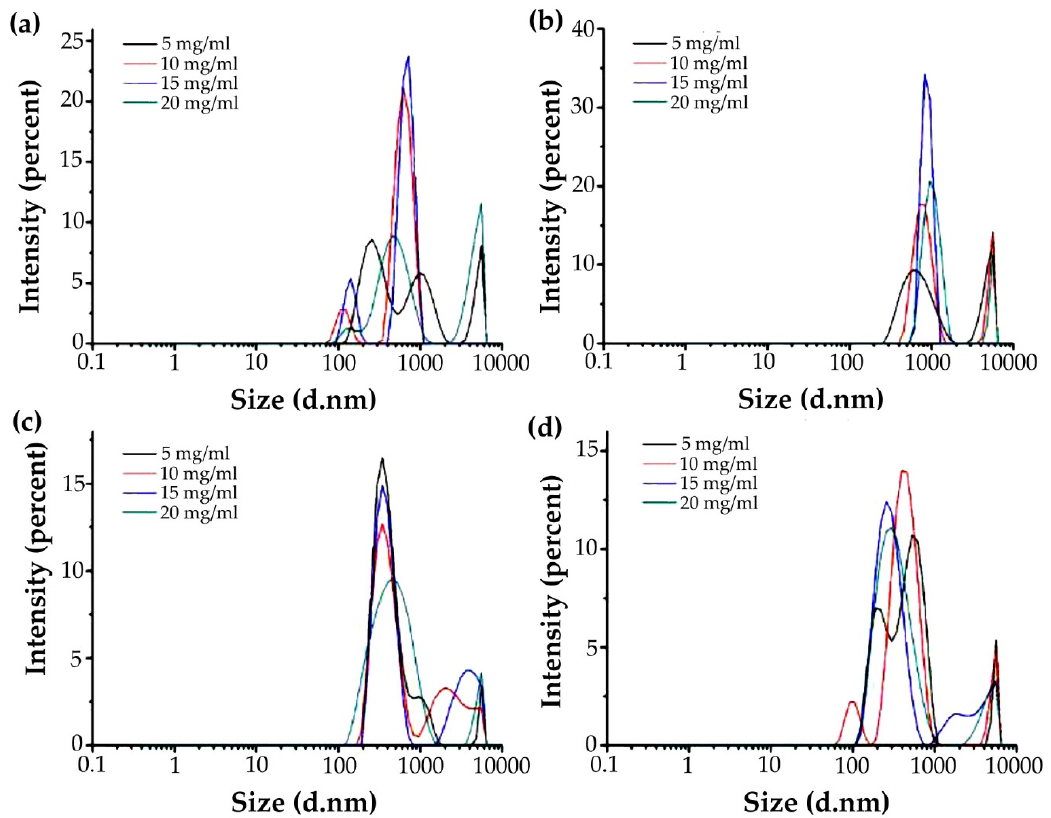
Figure 4. Particle size distribution of G ‐ MLPs at different concentrations. ( a ) G ‐ HBSS; ( b ) G ‐ CHSS; ( c ) G ‐ DASS; ( d ) G ‐ CASS.